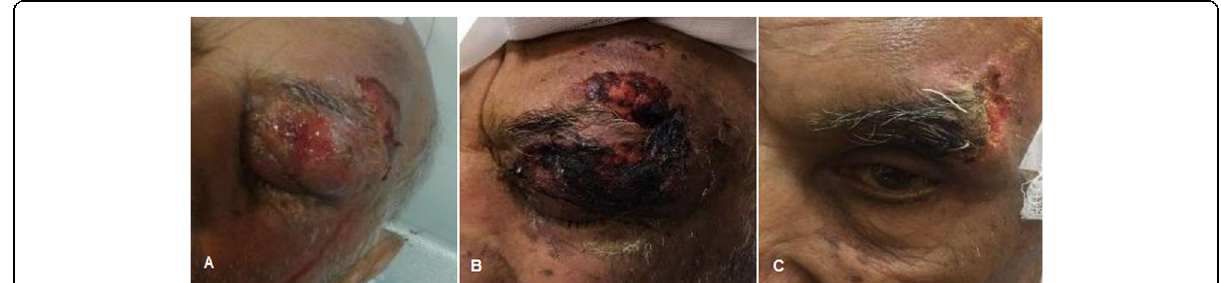
Fig. 8 A 70-year-old man with superior orbital cellulitis progressed to necrotizing fasciitis, a at presenting time external eye exam shows sever